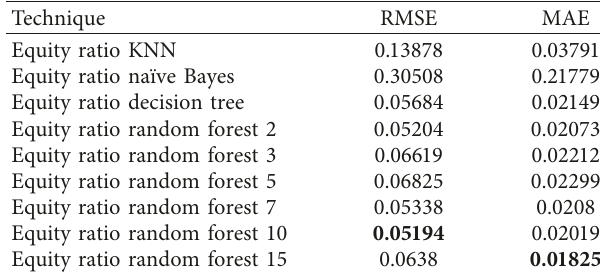
Table 3: Error measurement using KNN, SVM (linear and RBF), and na¨ıve